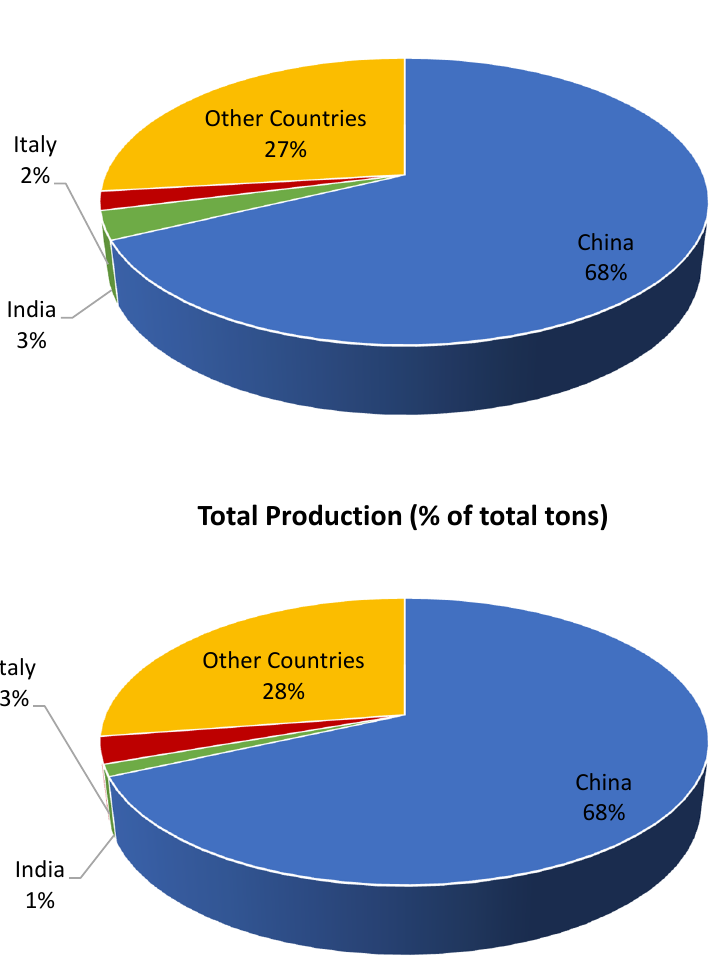
Table 1. Top 5 regions in fruit production and farm size in Italy.